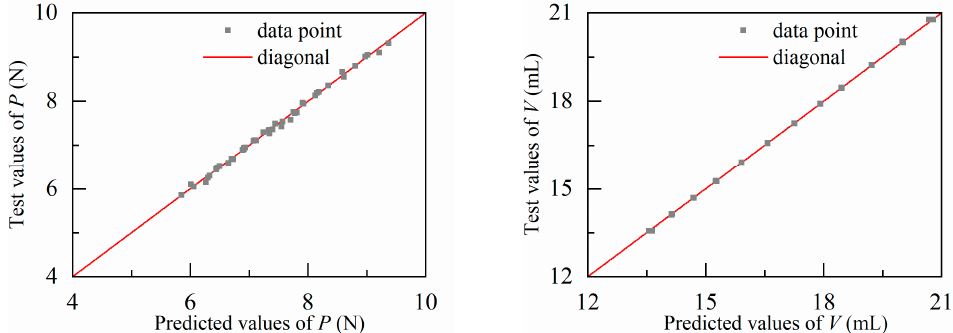
Figure 9. The comparison between predicted and test values.